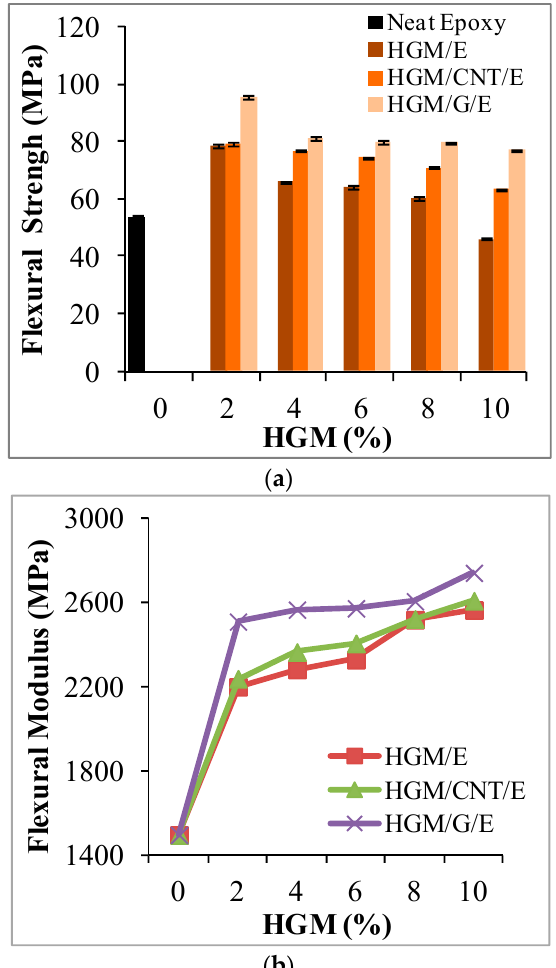
Figure 6. Flexural ( a ) strength and ( b ) modulus of composites.